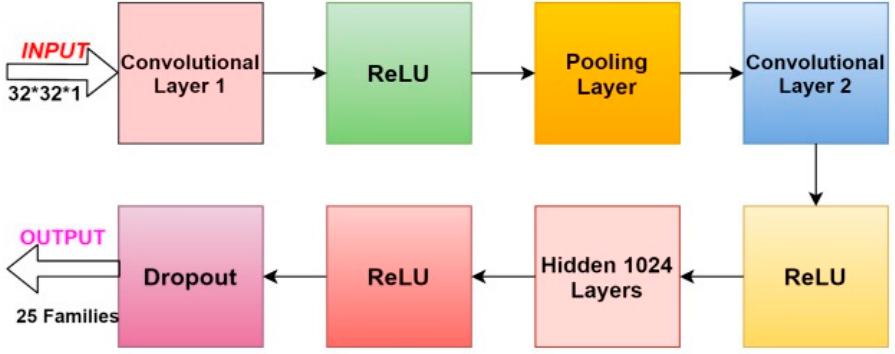
Figure 15. The deep network to detect malware attacks in 5G-IoT healthcare systems.